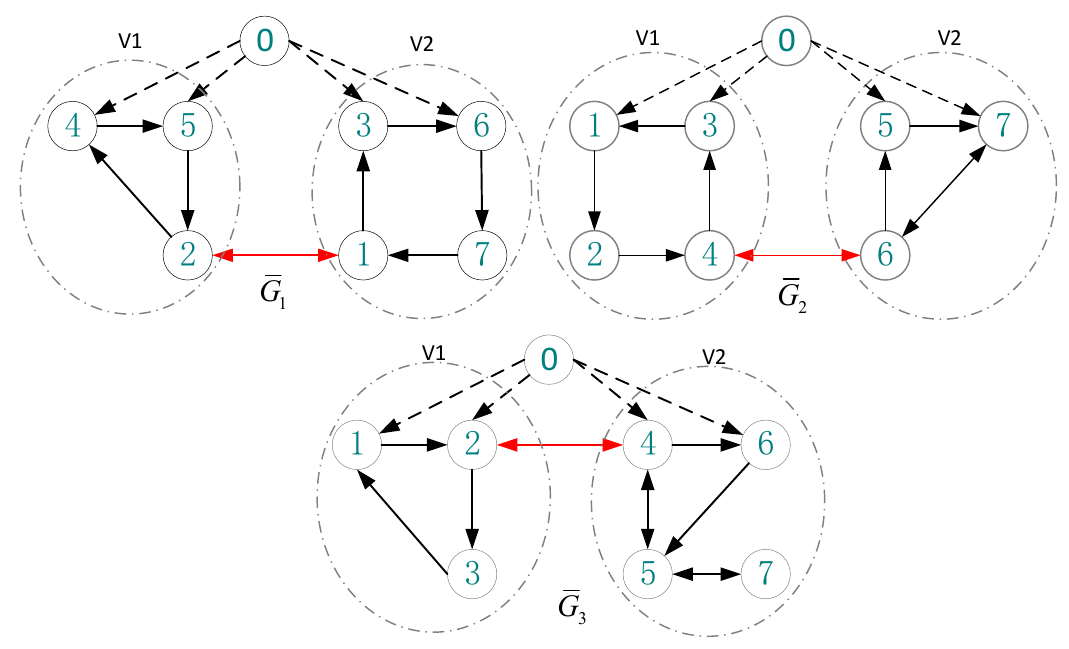
Figure 1. Communication topology among agents.